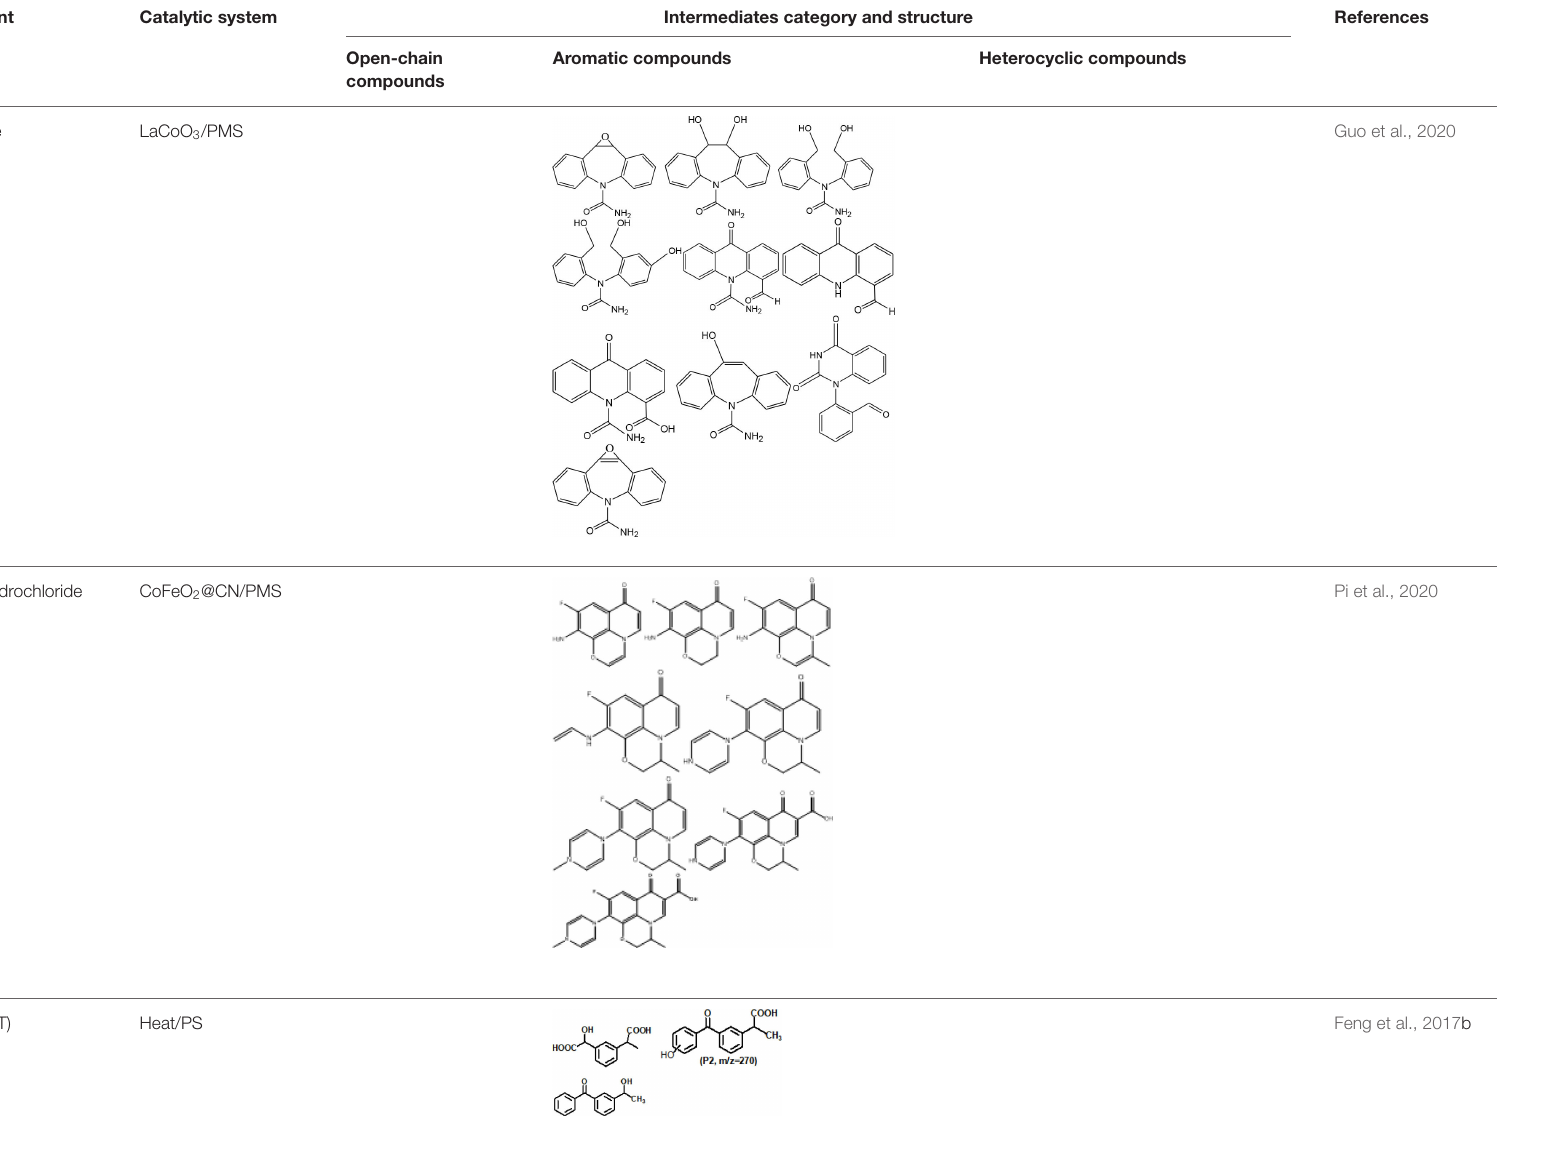
TABLE 3 | Chemical and structural characteristics of the intermediates of different pollutants during the PS/PMS